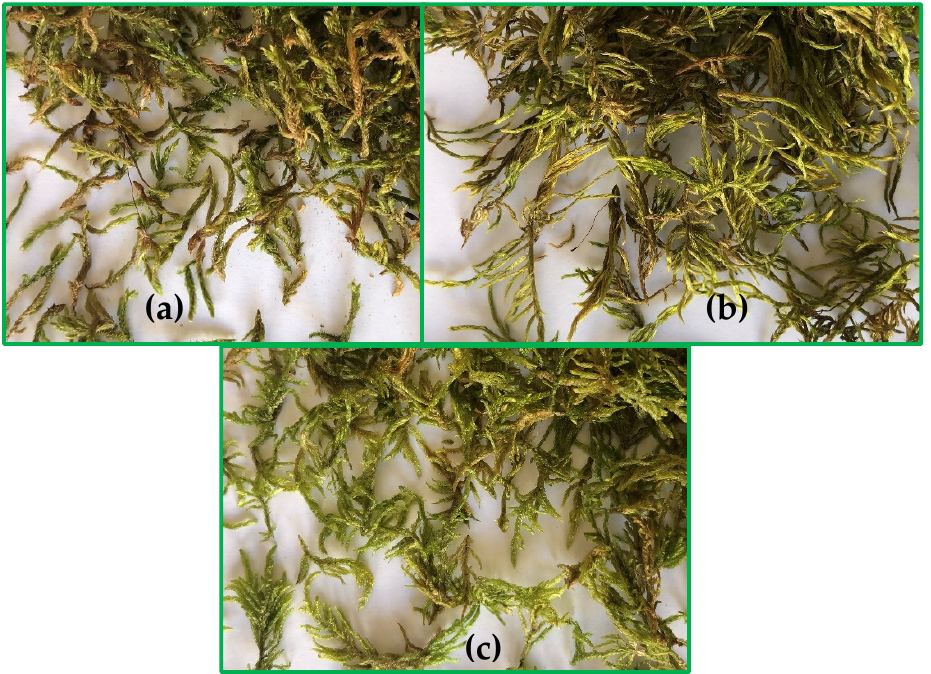
Figure 3. Types of mosses collected: ( a ) Hypnum cupressiforme Hedwig, 1801, ( b ) Homalothecium sericeum (Hedw.) Schimp. 1851, ( c ) Pseudoscleropodium purum (Hedw.) M.Fleisch.